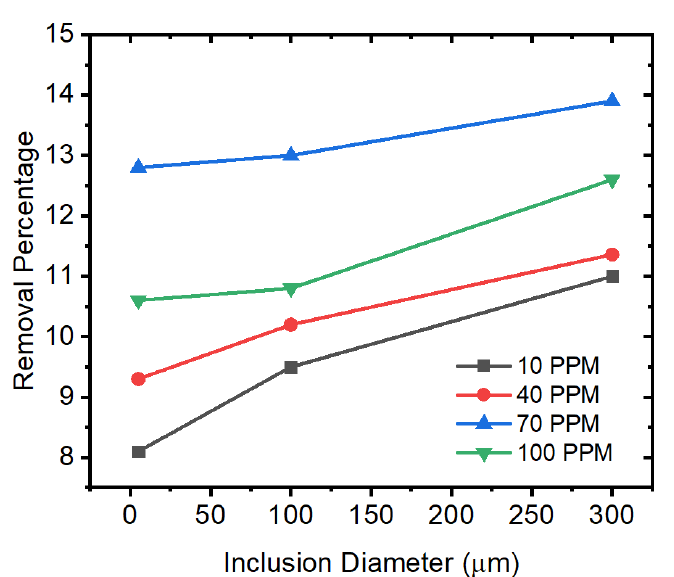
Figure 15. Removal percentage of alumina inclusions in different conditions of sulfur concentration and inclusion diameters.